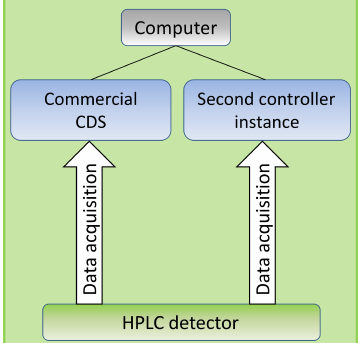
Figure 2. The network tracking of the data transmitted using TCP over the ethernet bypasses the not well-known storage procedure of the acquired raw data of the commercial